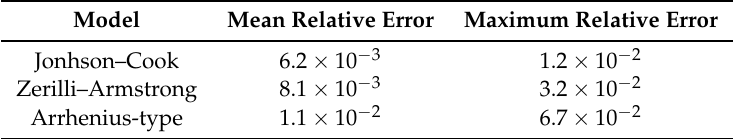
Table 4. Errors in the meta-model predictions of ∆ R compared with full FE